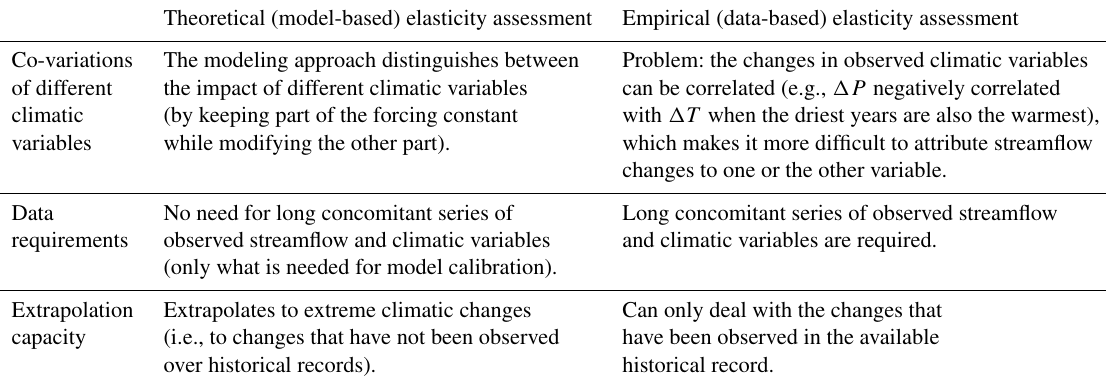
Table 2. Comparison of the theoretical and empirical elasticity assessment methods. Theoretical (model-based) elasticity assessment Empirical (data-based) elasticity